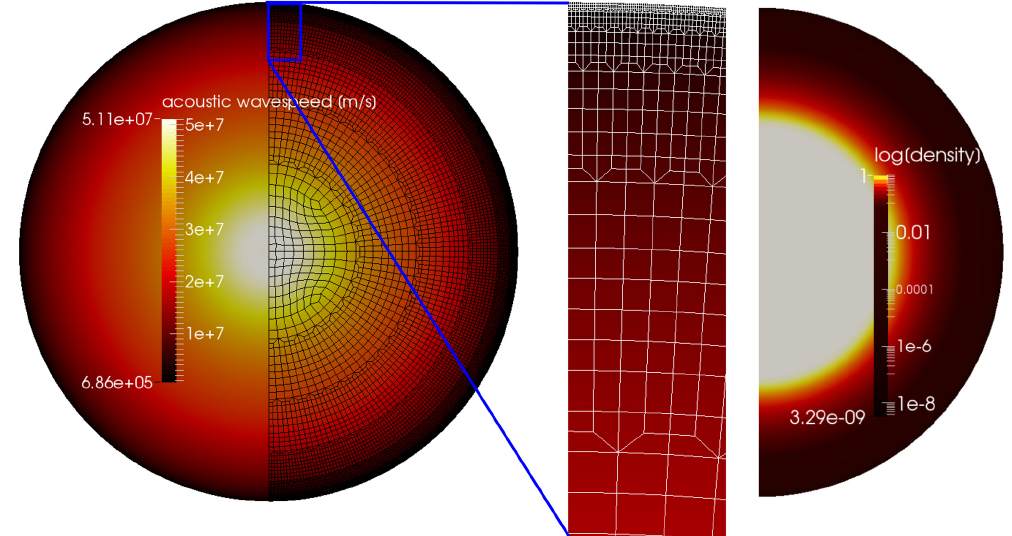
Figure 8. A mesh for the Sun’s interior that accommodates the radial structure of the Sun for frequencies up to 5mHz. It honors acoustic wavespeed variations of the Sun across two orders of magnitude (left), leading to seven coarsening (doubling) layers. Density (right) varies by eleven orders of magnitude, but does not affect the meshing process so long as these variations are smooth at the scale of elements. Such a mesh represents the basis for wave propagation and imaging the solar interior utilizing stochastic noise excitation within the framework of time–distance